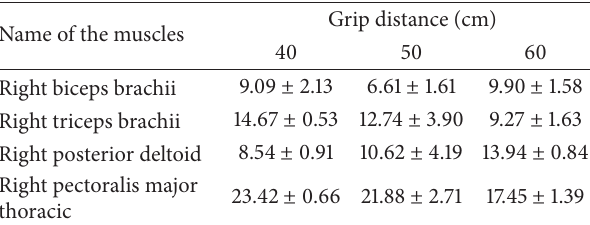
Table 4: Muscle electromyography mean/maximum average ratio (%) for four complete bench presses.